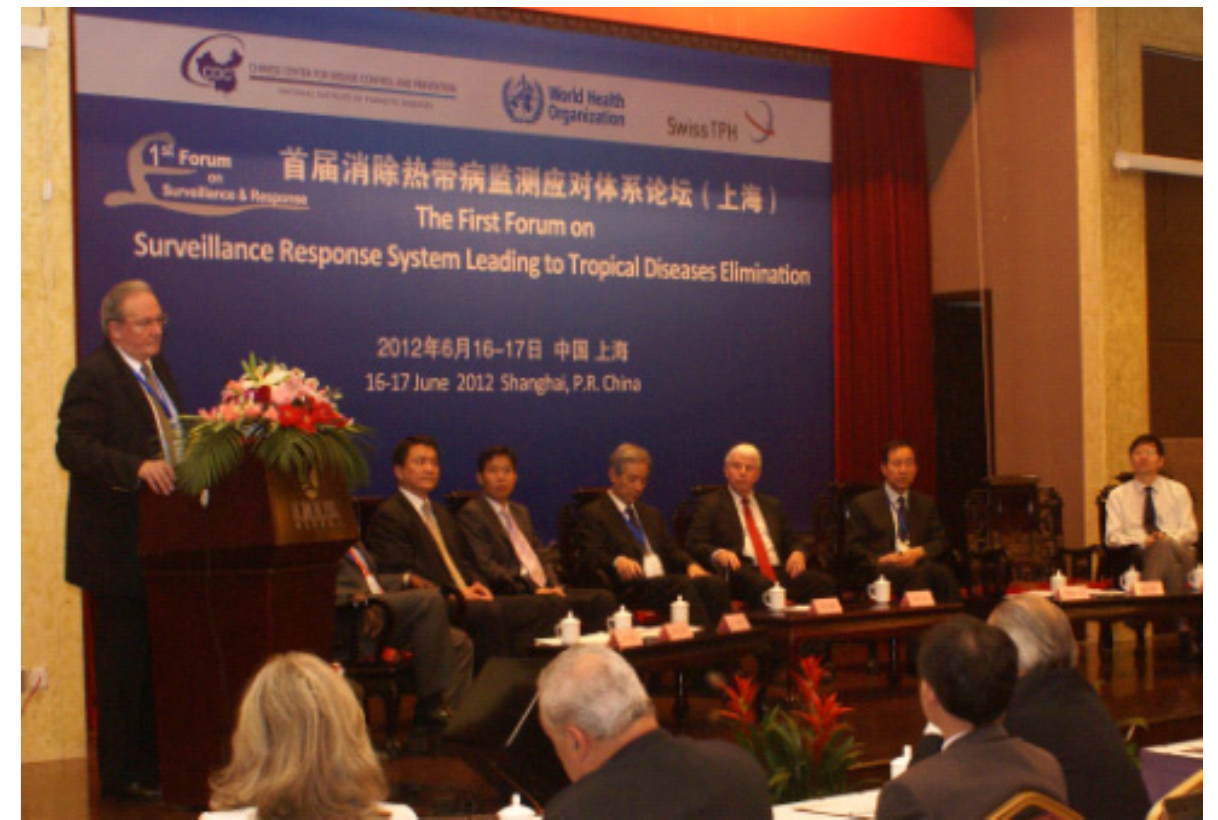
Figure 4. Professor Tanner, giving the opening speech as Chairman of the First Forum on Surveillance and Response System Leading to Tropical Diseases Elimination in Shanghai 2012.